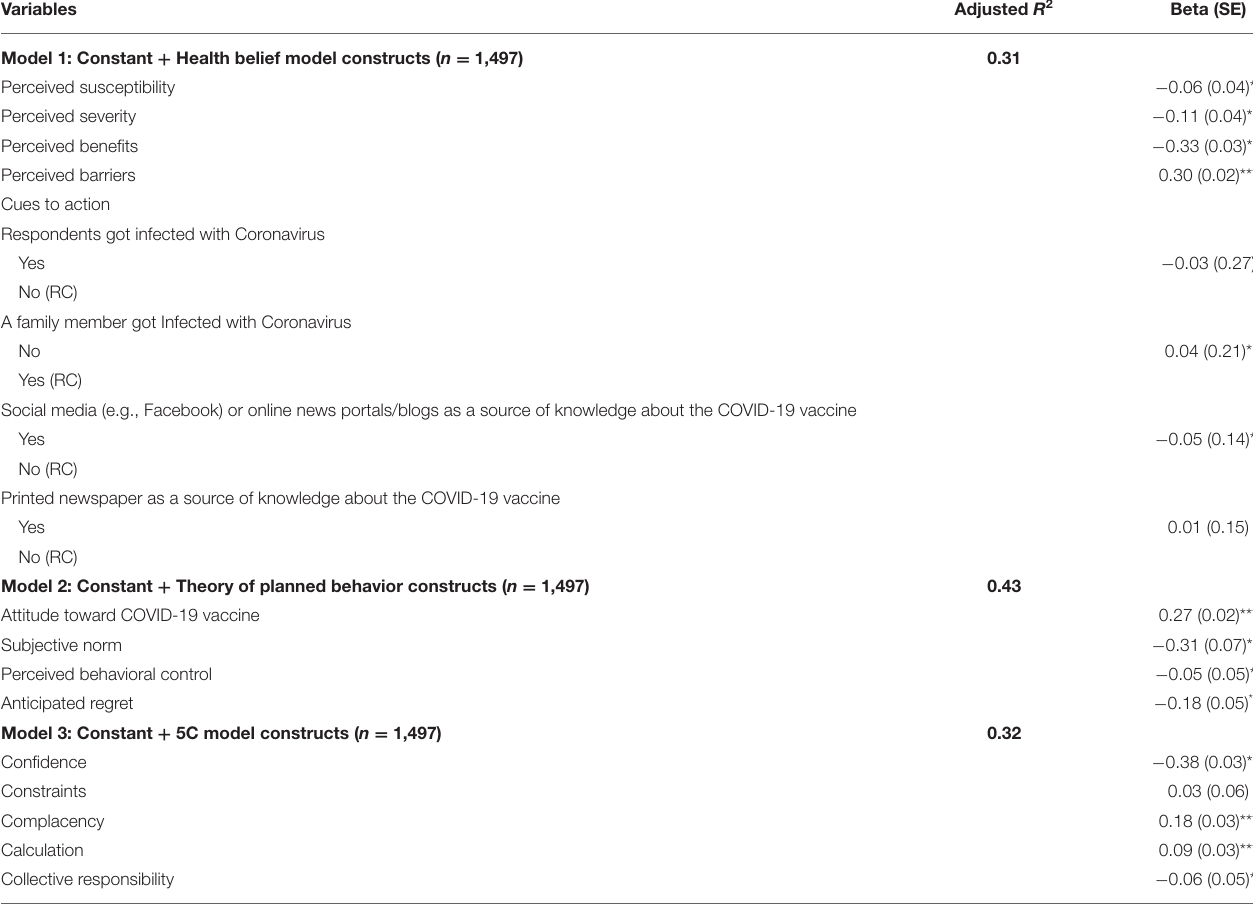
TABLE 3 | Multiple linear regression analysis to predict COVID-19 vaccine hesitancy.